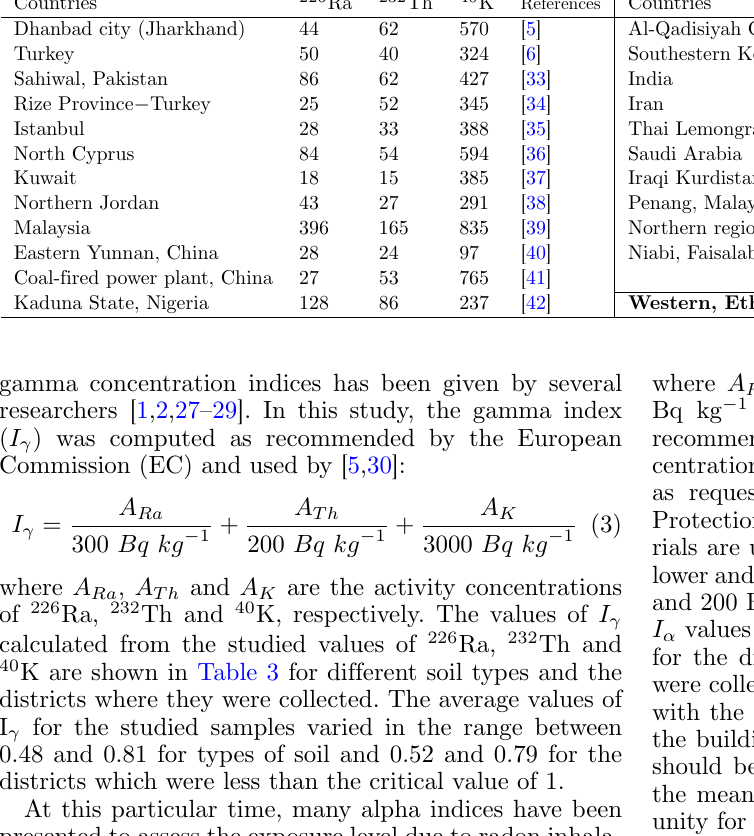
(cid:0) (cid:1) Bq kg − 1 of 226 Ra, 232 Th and 40 K in selected soil samples according to